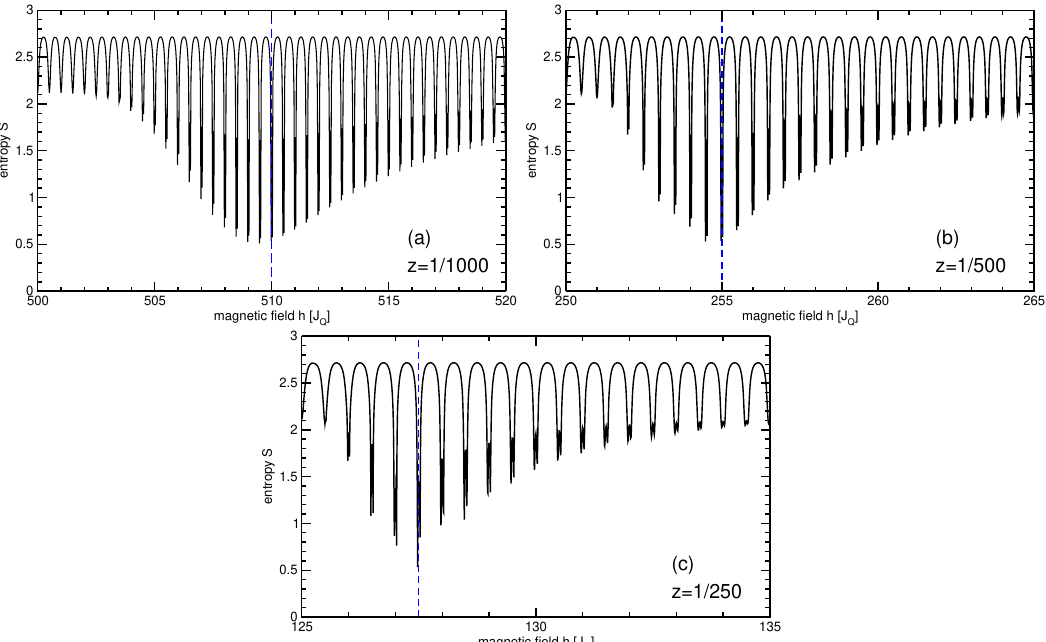
Figure 6: (a) Residual entropy as function of the applied magnetic field for = 0.02 J N = 3, J , and z = 1 / 1000 to show the position at h = 2 π/ ( zT max Q + J / 2 ) / z of the nuclear magnetic resonance. (b) the shift, dashed line at ≈ ( 0.5 J Q max Same as (a) for z = 1 / 500. (c) Same as (a) for z = 1 /